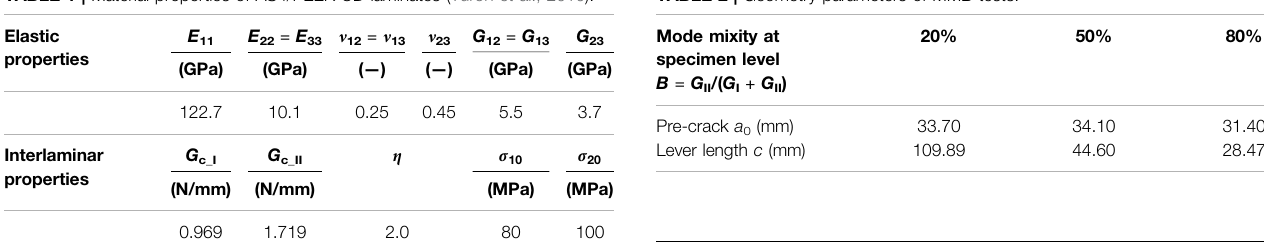
TABLE 1 | Material properties of AS4/PEEK UD laminates (Turon et al., 2010). TABLE 2 | Geometry parameters of MMB tests.